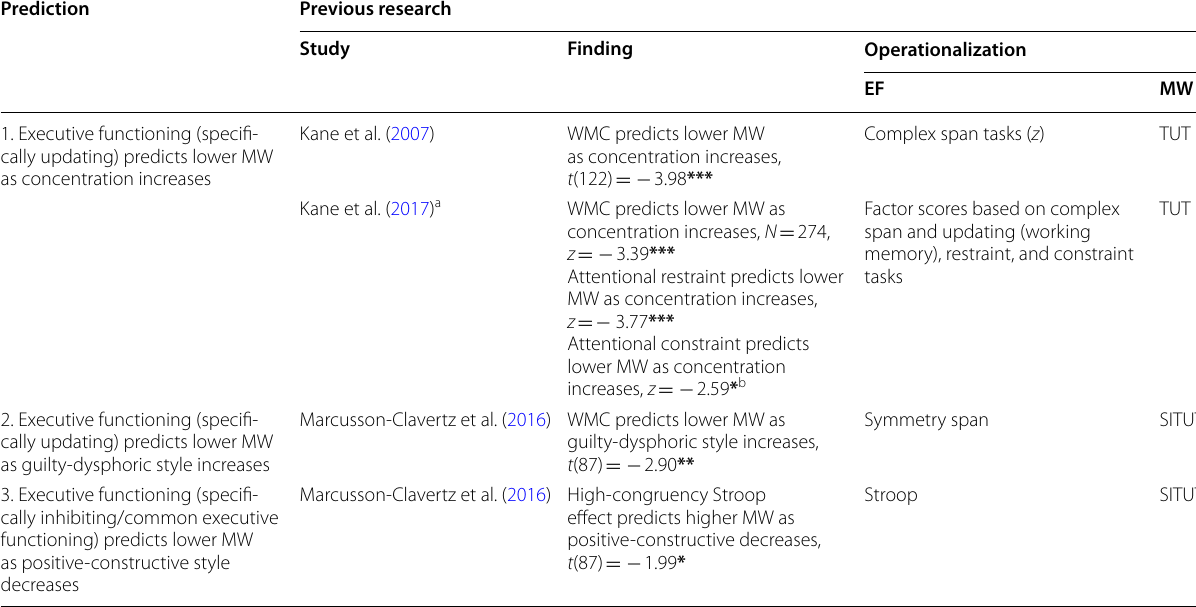
Table 1 Summary of predictions of mind wandering (MW) and the previous research they were based